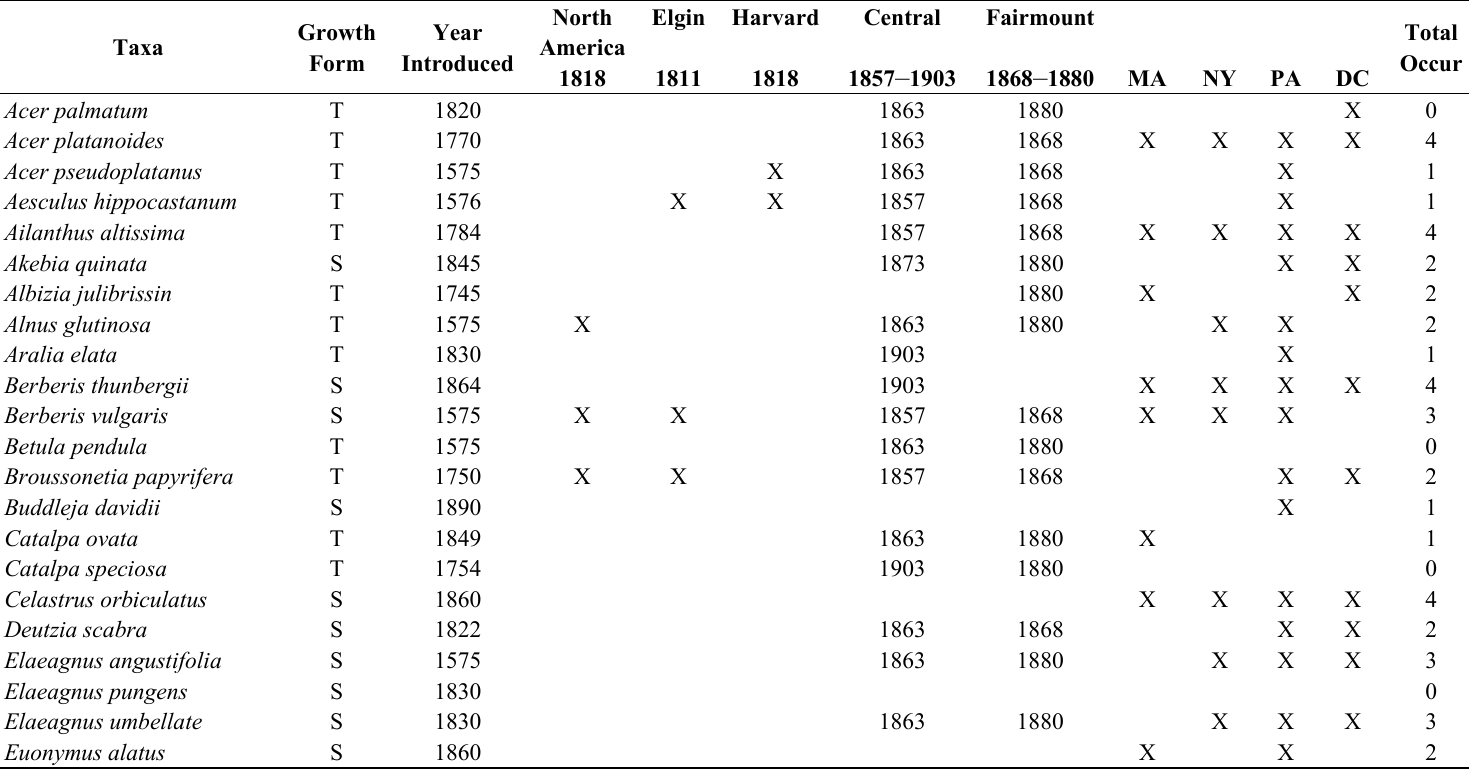
Table 3. Presence of invasive trees and shrubs as listed in the Mid-Atlantic Exotic Pest Plant Council Plant List [38] in floras: North America of 1818 [41]; Elgin Botanical Gardens, New York of 1811 [40]; Harvard Botanical Gardens, Boston of 1818 [42]; Central Park, New York from 1857 to 1903 [6]; and Fairmount Park, Philadelphia from 1868 to 1880 [6]. State level invasive taxon designation is for Massachusetts (MA), New York (NY), Pennsylvania (PA), and the District of Columbia (DC) [38]. Species binomials and growth form (tree–T and shrub–S) follow Hortus Third [37]. Year introduced into arboriculture follows the Manual of Cultivated Trees and Shrubs [39]. Total is the sum of the taxa reported for particular floras as well as the state level designations as an invasive and Total Occurrence (Total Occur) is the sum of all occurrences of each taxon in the four state